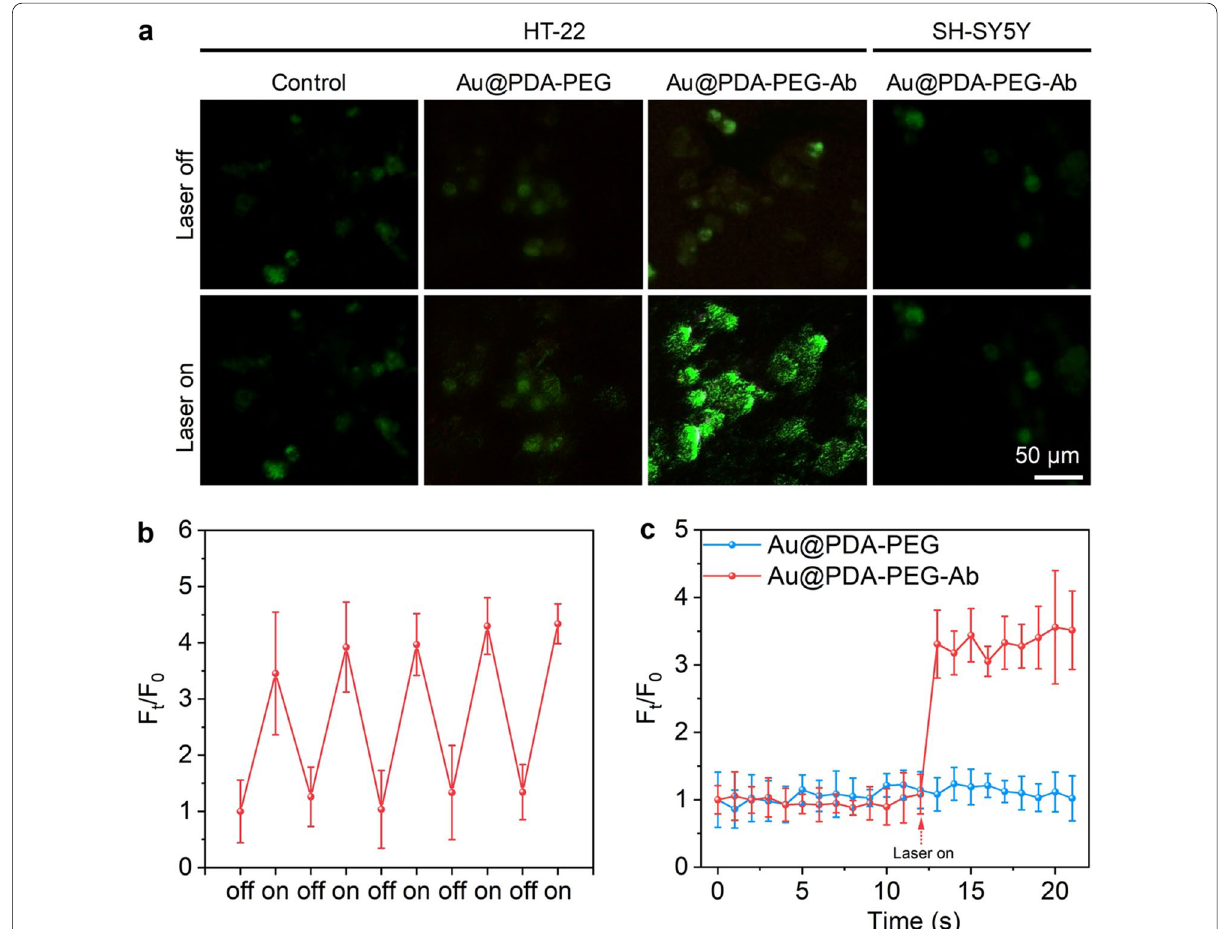
Fig. 5 NIR-II photothermal activation of TRPV1 in HT-22 and SH-SY5Y neurons. a Fluorescent images of HT-22 or SH-SY5Y cells treated with Au@ PDA-PEG or Au@PDA-PEG-Ab before and after laser irradiation at 1064 nm (0.5 W/cm 2 ) for 1 s. b Changes in the Fluo-4 fluorescence intensity with the 1064 nm laser switching on and off at 1 s intervals. c The fluorescence intensity of Fluo-4 as a function of laser irradiation